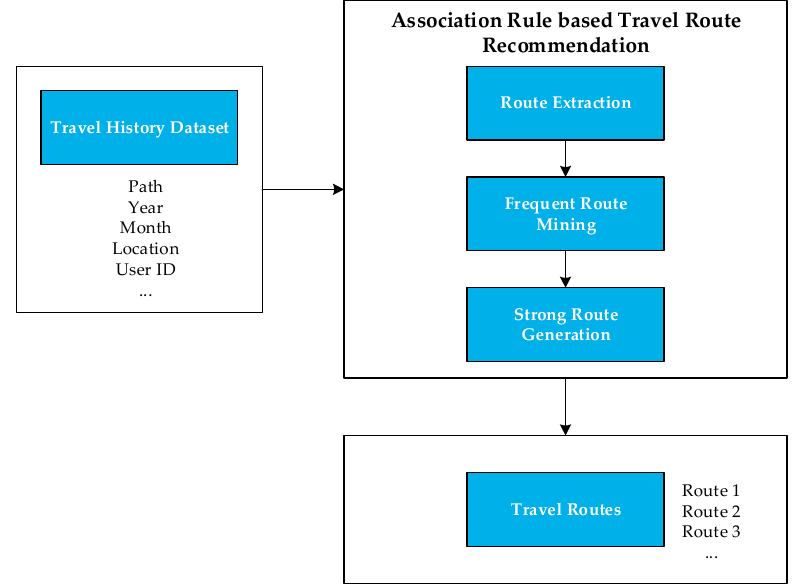
Figure 2. Architecture of the association rule mining travel route recommendation module.